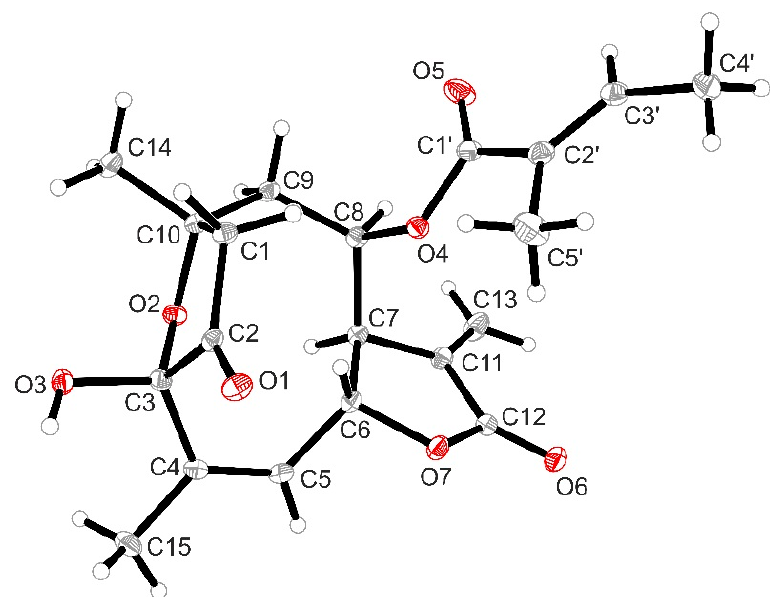
Figure 1. Structures of the isolated STLs (sesquiterpene lactones).